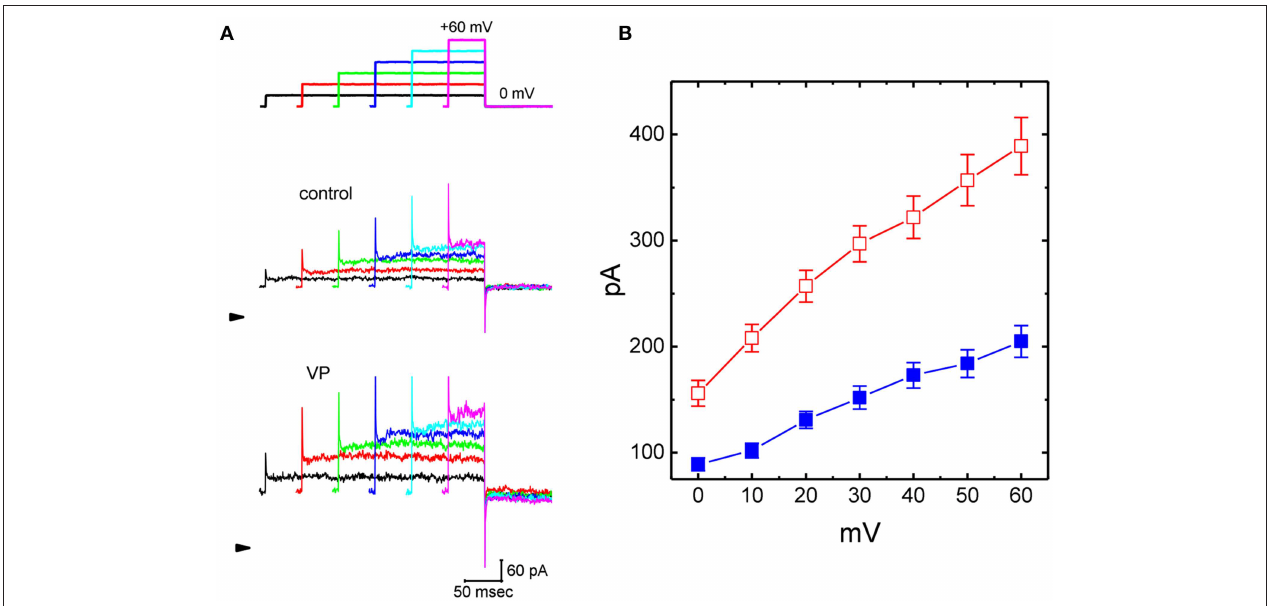
FIGURE 1 | Effects of verteporfin (VP) on Ca 2 + -activated K + current ( I K(Ca) ) measured from pituitary GH 3 cells. In these experiments, cells were bathed in normal Tyrode’s solution containing 1.8mM CaCl 2 , and the recording pipette was filled with K + -containing solution. The examined cell was voltage clamped at 0mV to inactivate most of other types of voltage-gated K + currents, and a series of the voltage steps ranging between 0 and + 60mV [indicated in the uppermost part of (A) ] was delivered. (A) Representative I K(Ca) traces taken in the absence (upper) and presence (lower) of 3 µ M VP. The arrowhead indicates the zero current level, and calibration bar in the bottom right corner refers to both panels. (B) Averaged current-voltage ( I-V ) relationships of I K(Ca) measured from the control ( (cid:4) ) and during cell exposure to 3 µ M VP ( (cid:3) ) (mean ± SEM; n = 11 for each